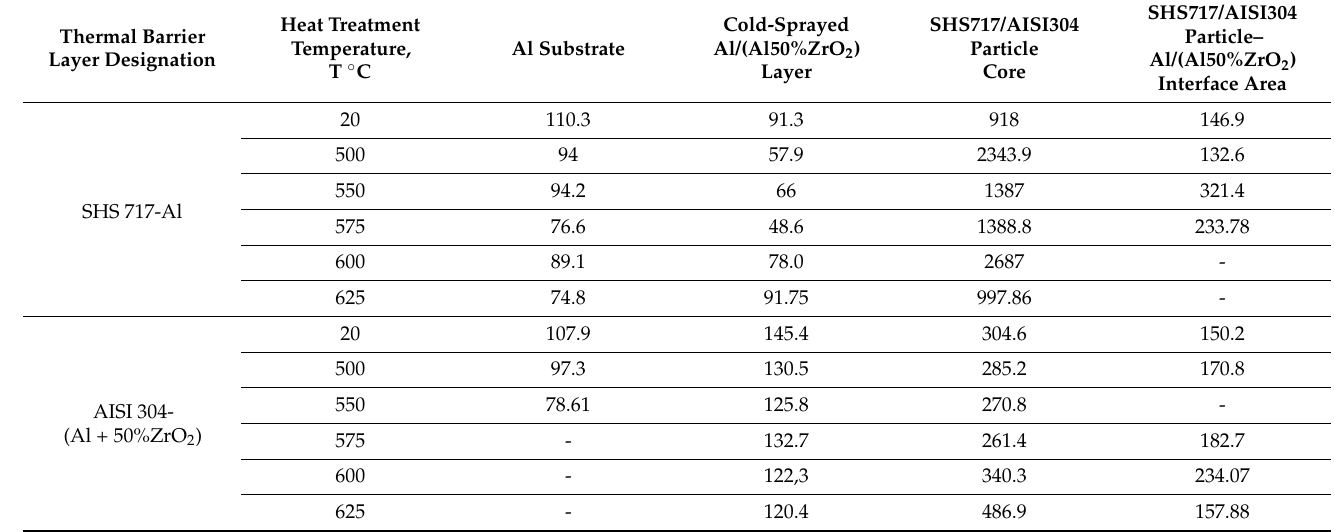
Table 6. Microhardness of coatings after heat treatment at various temperatures.